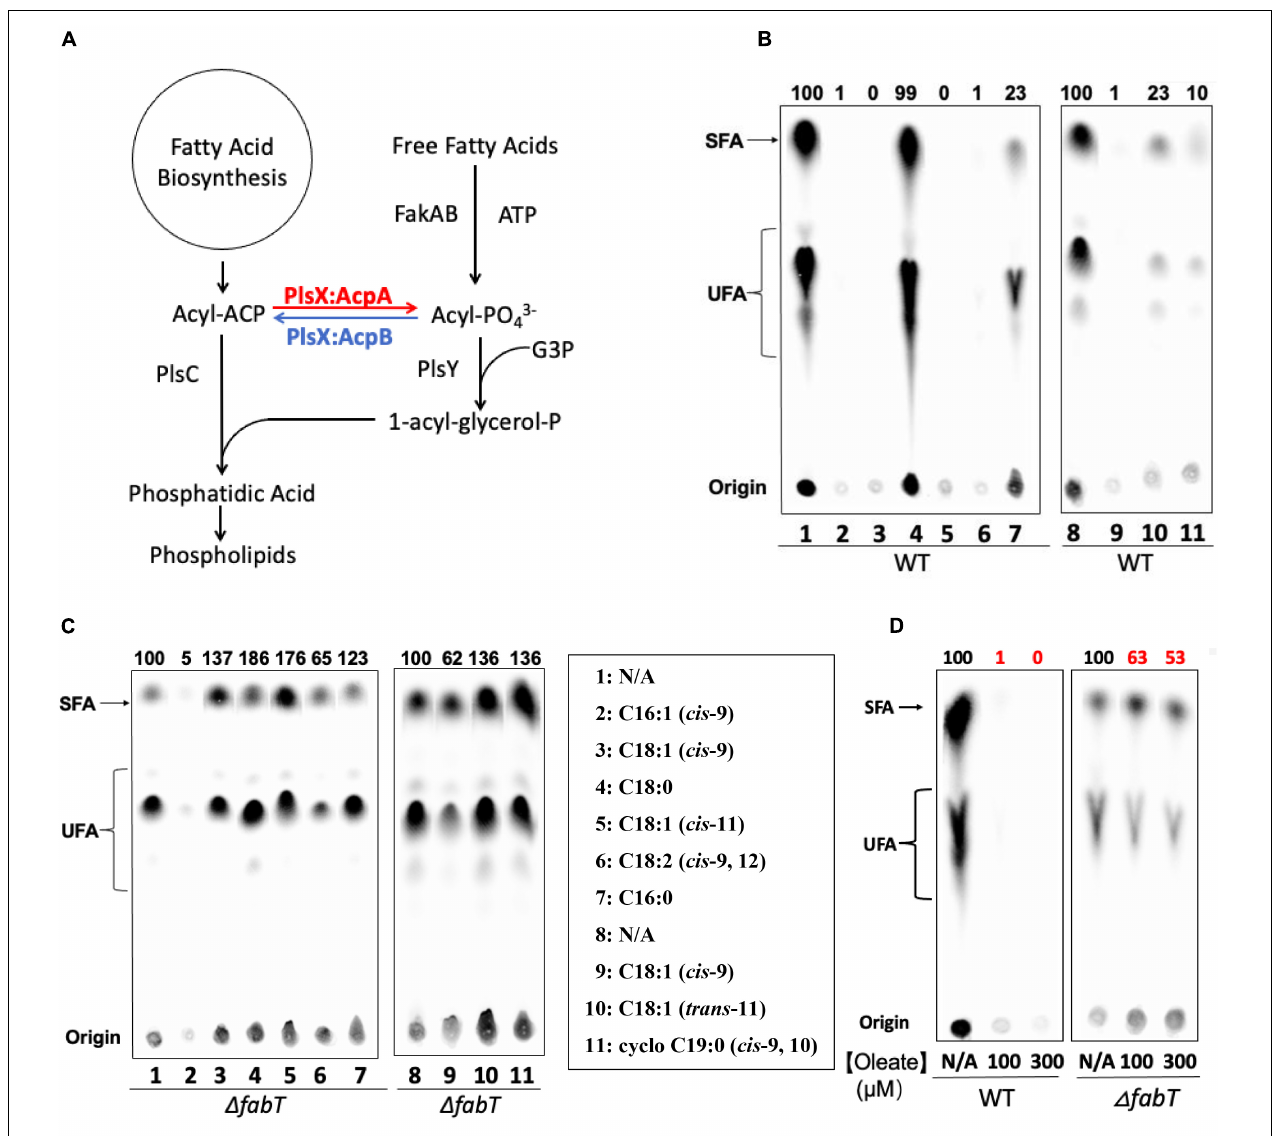
FIGURE 1 | Exogenous fatty acids regulate E. faecalis de novo fatty acid biosynthesis by the FabT-transcription factor. (A) The E. faecalis phospholipid synthesis pathway. (B) De novo fatty acid biosynthesis in the wild type E. faecalis in the presence of exogenous fatty acids. (C) De novo fatty acid biosynthesis in the E. faecalis (cid:49) fabT strain in the presence of exogenous fatty acids (100 µ M for each fatty acid). (D) De novo fatty acid biosynthesis of E. faecalis wild-type and (cid:49) fabT strains in the presence of 100 or 300 µ M oleate. For panels (B,C) , At the left of lane 1 a lane of cells grown with 10-hydroxyl stearic acid was deleted since this fatty acid is not found in E. faecalis . In panel (D), three lanes of (cid:49) acpB (ZL318) cells between the WT and (cid:49) fabT groups were deleted because of the missense mutation later detected in fabT gene of this strain (see